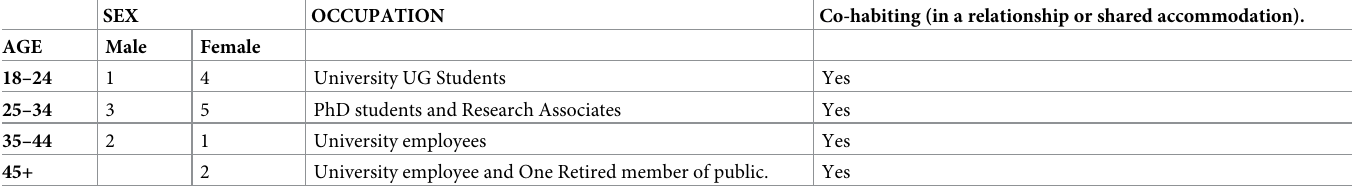
Table 1. Demographic breakdown of